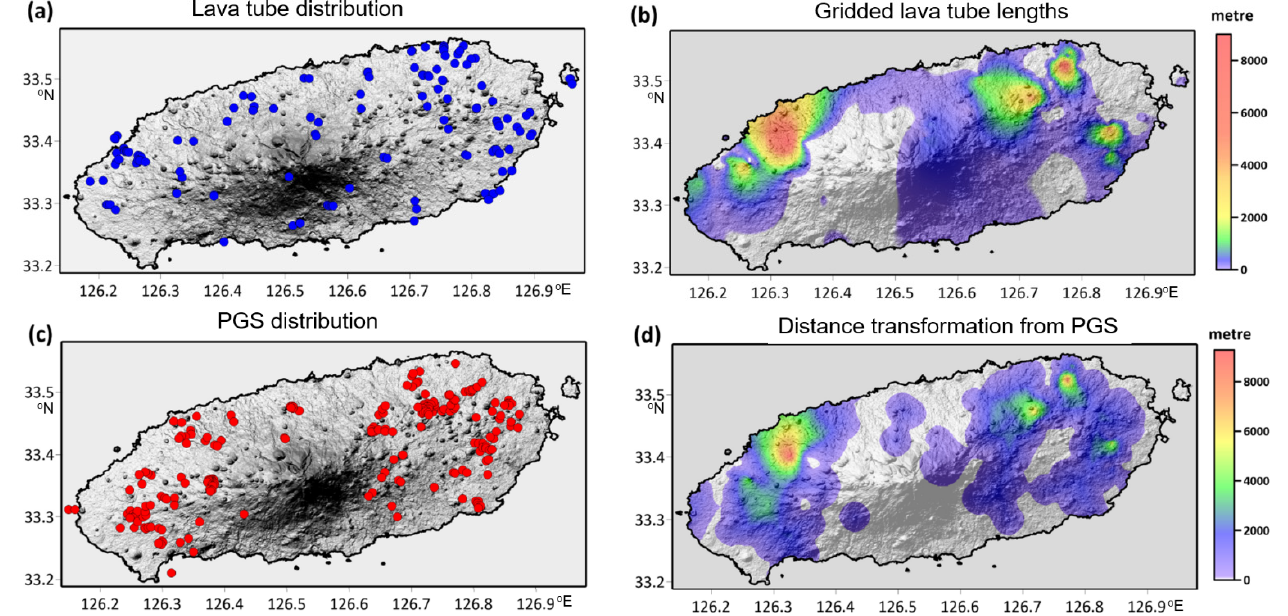
Figure 5. Spatial analyses to create processing mask. ( a ) Lava tube distributions and ( b ) density map of lava tubes calculated with the weighted tube length. ( c ) PGS distributions and ( d ) distance transformation map of PGS.